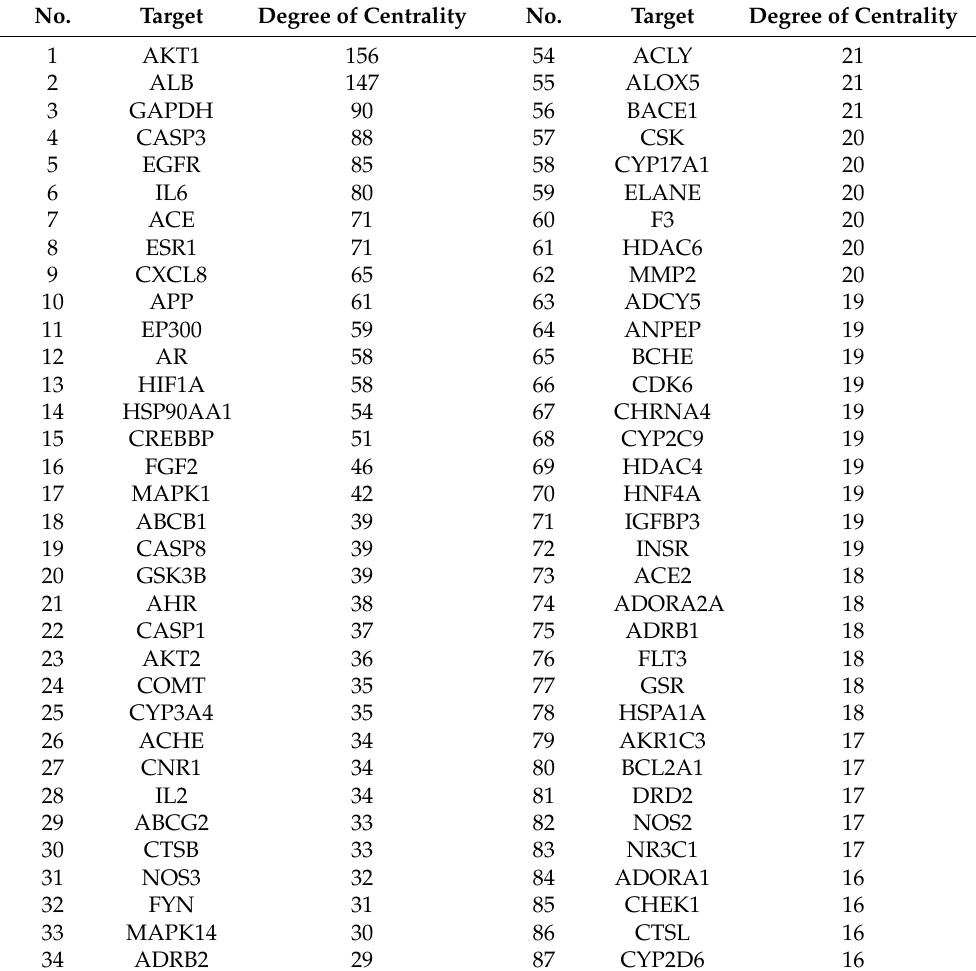
Table 2. The degree of to 30% DC targets.